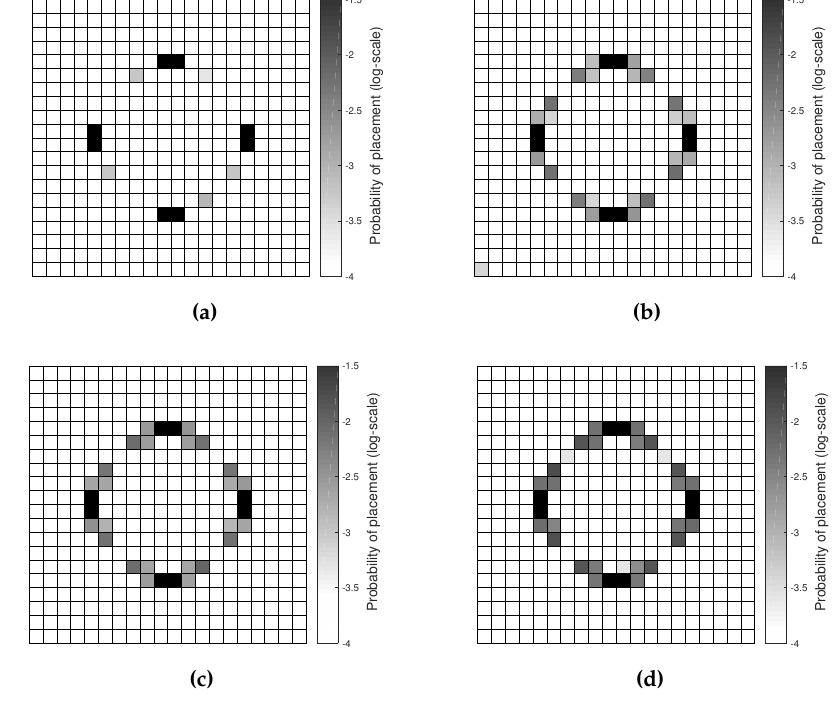
Figure 4. Plate problem, macroscale analysis, N M = 8: probability of (optimal) sensor placement considering ( a ) FBW = 50 Hz; ( b ) FBW = 200 Hz; ( c ) FBW = 400 Hz; and ( d ) FBW = 800